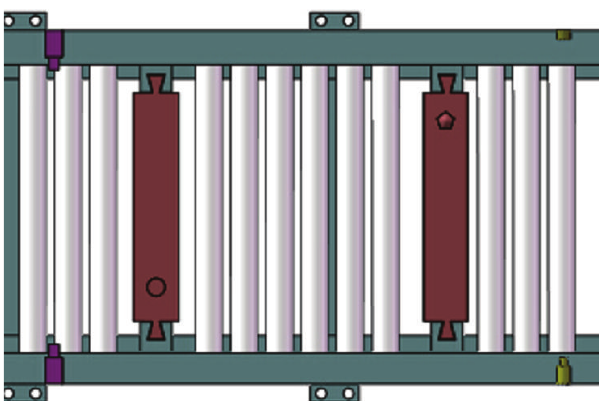
Figure 3: Positioning platform.